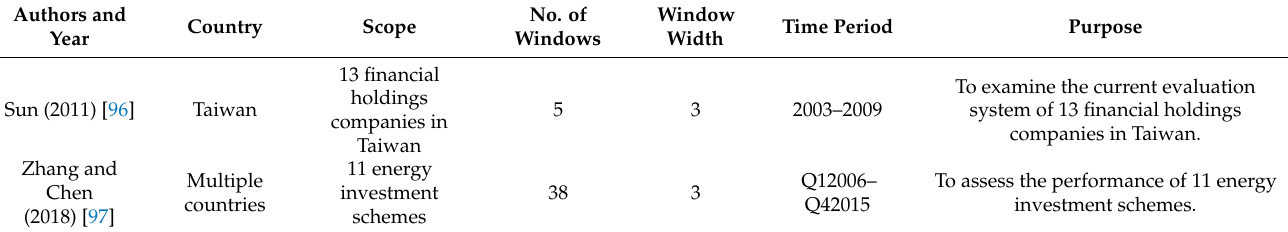
Table 12. Articles classified under the finance category.